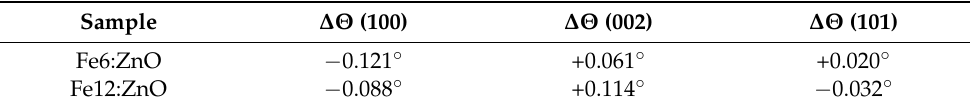
Table 4. Diffraction angle shifts on the peaks corresponding to the (100), (002) and (101) planes with respect to the ZnO NPs. ∆ θ = θ Fe:ZnO − θ ZnO .